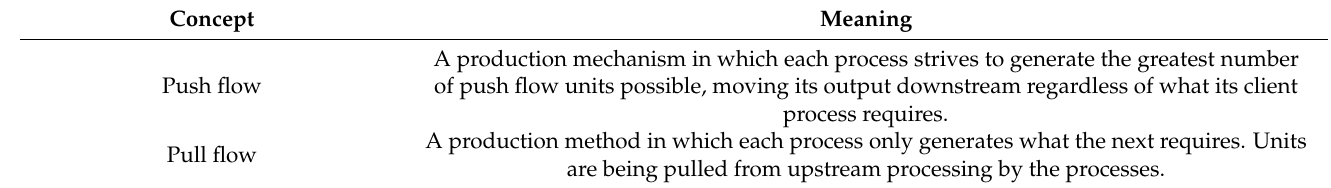
Table 6. VSM concepts